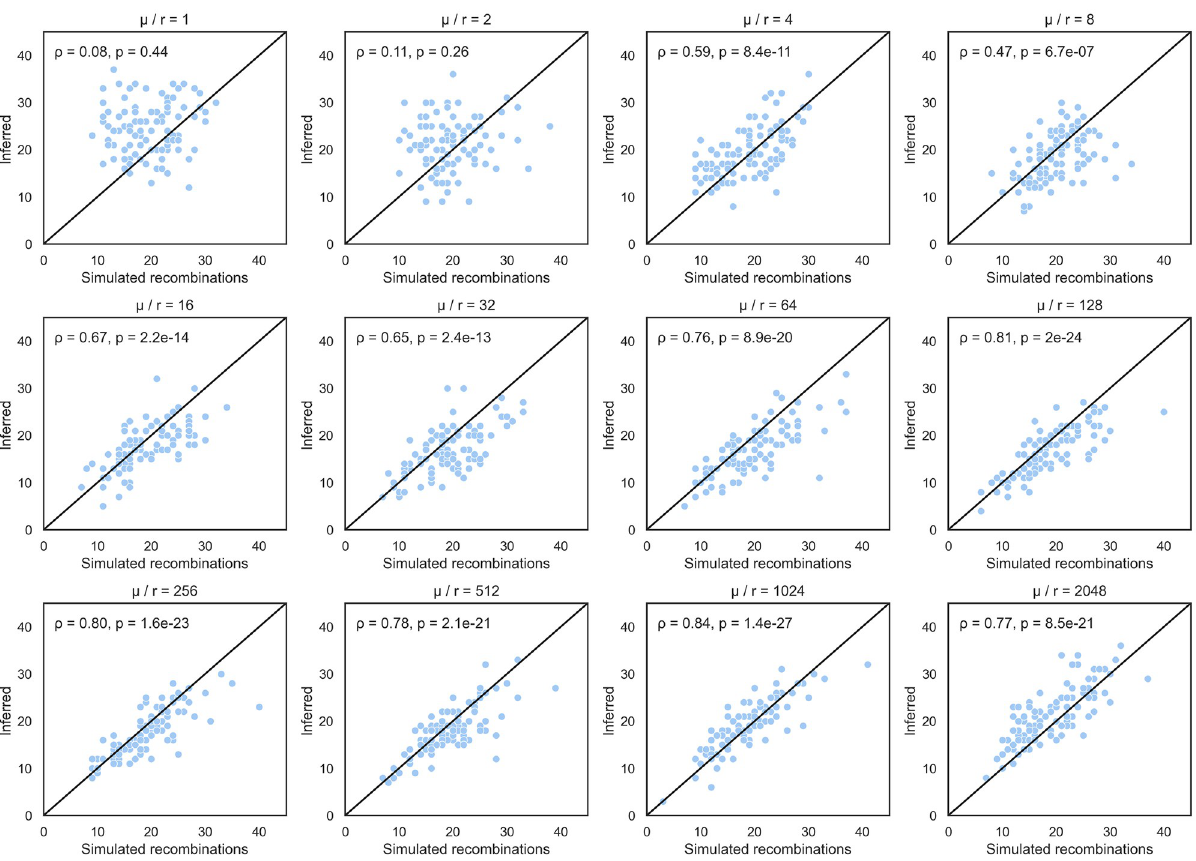
Fig 3. Simulated number of recombination events versus number inferred by ARGweaver under different ratios of mutation rate / recombination rate. Each diagonal line is x = y . ρ and p are the correlation coefficient between the simulated and estimated number of events and corresponding p- value, respectively. We selected the ARG sampled by ARGweaver during the final MCMC iteration to count the number of recombination